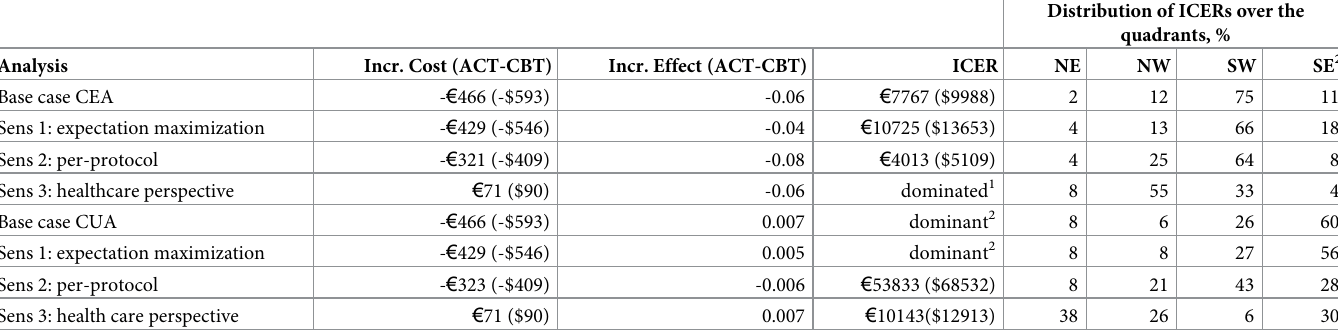
Table 3. Result of the main analyses (cost-effectiveness and cost-utility) and sensitivity